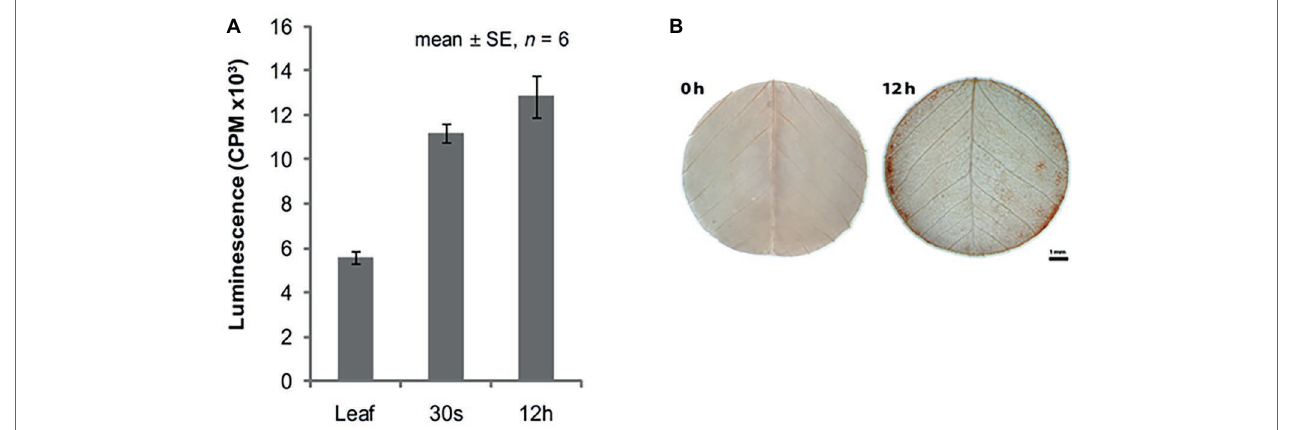
FIGURE 3 | ROS in relation to somatic embryogenesis induction. (A) ROS production in leaf explants. (B) DAB (3,3'-diaminobenzidine) staining for H 2 O 2 . Bar = 1 mm. (A,B) reproduced with permission from Wang et al.,